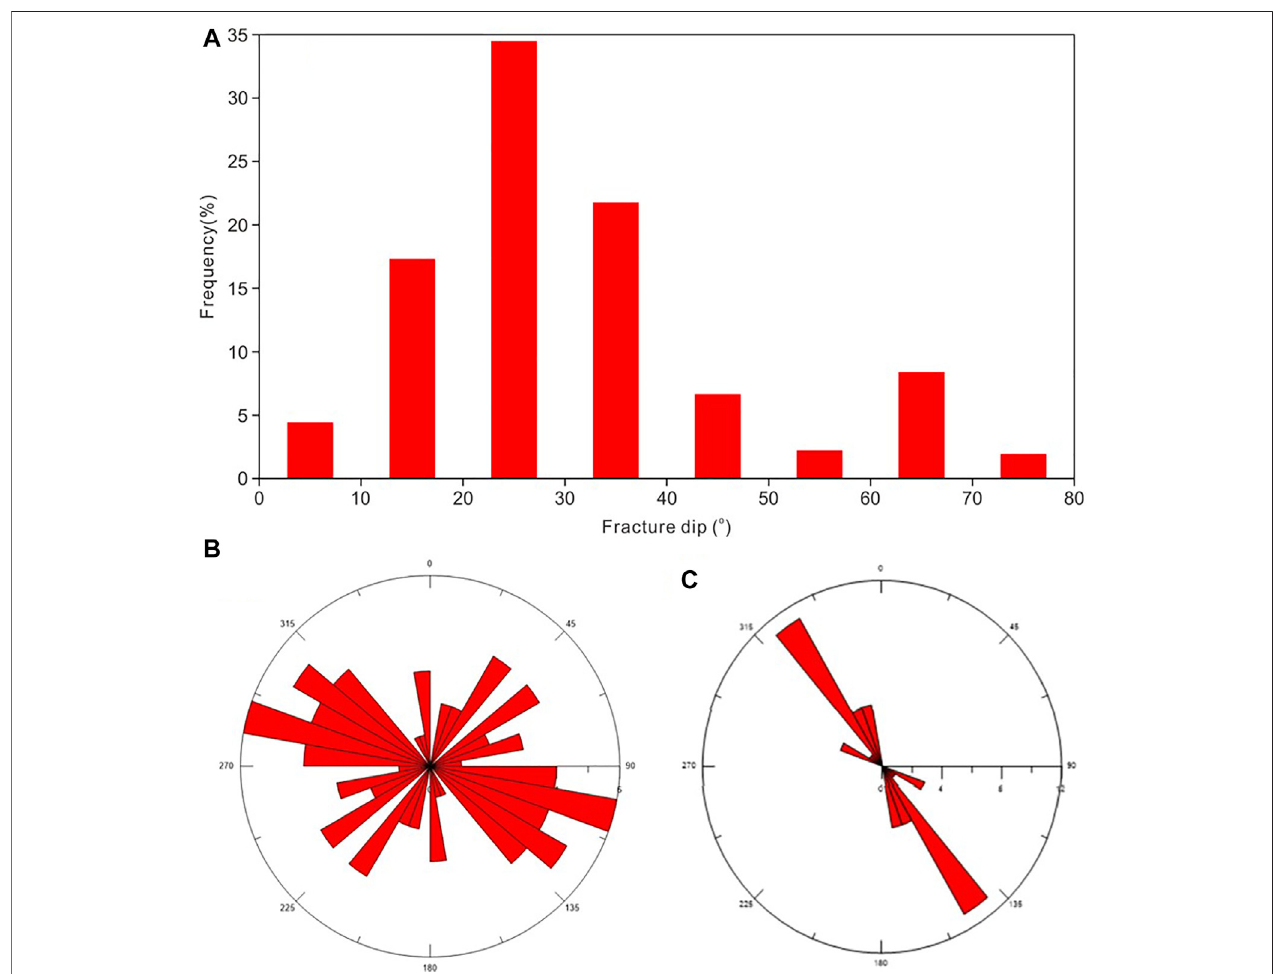
FIGURE 9 | The characteristics of natural fractures identi fi ed by imaging logging in the LD-A gas fi eld. (A) Frequency distribution histogram of the inclination of fractures, (B) rose diagrams of natural fracture strikes, and (C) rose diagrams of induced fracture strikes.